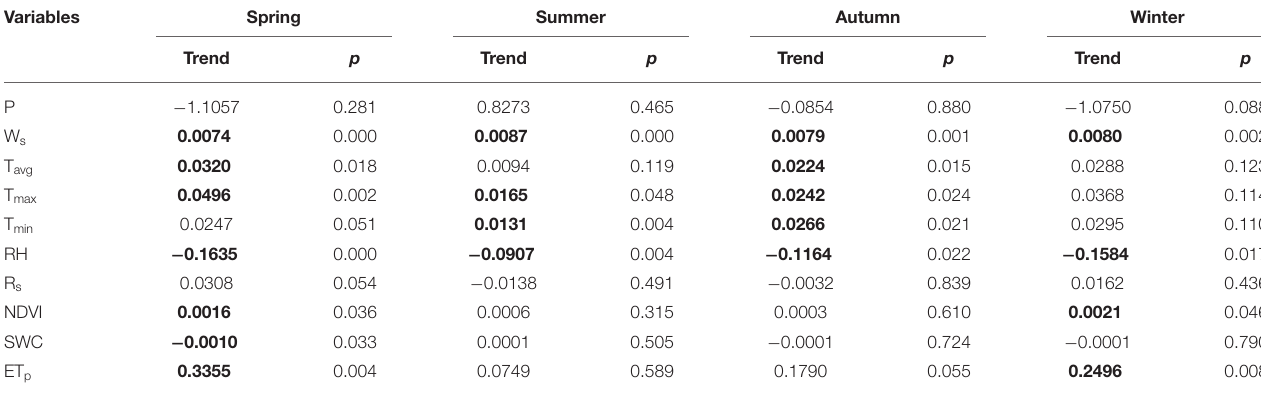
TABLE 2 | Linear trends and p -values for the variables in Figure 4 . Variables Spring Summer Autumn Winter Trend p Trend p Trend p Trend